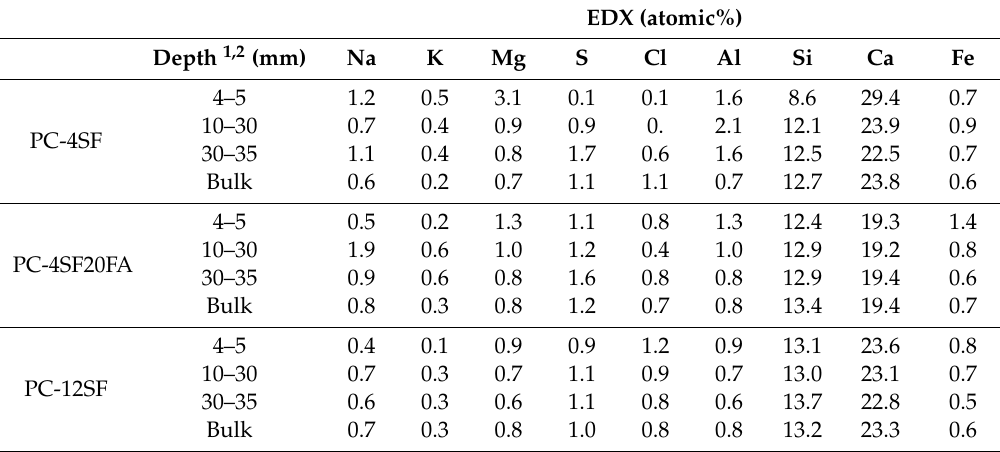
Table 5. Elemental composition measured by the EDX point analysis of the paste ( a ) close to the crack ( < 0.1 mm distance from the crack face) at di ff erent crack depth from the exterior and ( b ) in the bulk of the